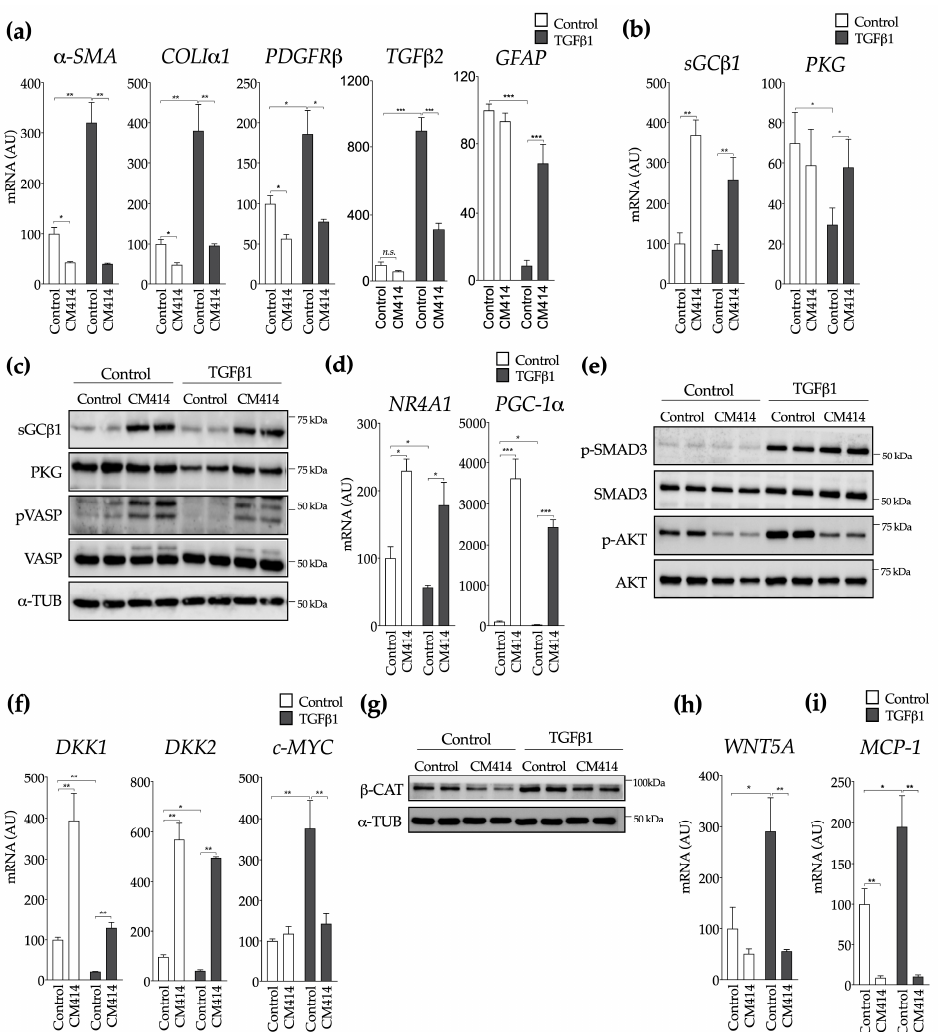
Figure 6. E ff ect of CM414 on transforming growth factor β (TGF β )1-mediated activation of LX2 cells. In all experiments LX2 cells were treated with CM414 (5 µ M) for 1 h and then stimulated with TGF β 1 (5 ng / mL) for another 24 h. ( a ) qPCR analysis of the expression of genes involved in fibrogenic activation. ( b ) qPCR analysis of the expression of sGC β 1 and protein kinase G (PKG). ( c ) immunoblot analysis of sGC β 1, PKG, phospho-VASP, VASP, and α -TUB protein levels in LX2 cells treated as indicated. ( d ) qPCR analysis of the expression of nuclear receptor 4 A1 (NR4A1) and proliferator activated receptor gamma co-activator-1 α (PGC-1 α ) in LX2 cells treated as indicated. ( e ) immunoblot analyses of phospho-SMAD3, SMAD3, phospho-AKT and AKT protein levels in LX2 cells treated as indicated. ( f ) qPCR analyses of DKK1, DKK2, and c-MYC expression in LX2 cells treated as indicated. ( g ) immunoblot analyses of activated β -catenin ( β -CAT) and α -TUB protein levels in LX2 cells treated as indicated. ( h ) qPCR analyses of WNT-5A expression in LX2 cells treated as indicated. ( i ) qPCR analysis of monocyte chemoattractant protein 1 (MCP1) mRNA expression in LX2 cells treated as indicated. Representative blots of three experiments performed in duplicate are shown. * p < 0.05. ** p < 0.01. *** p <